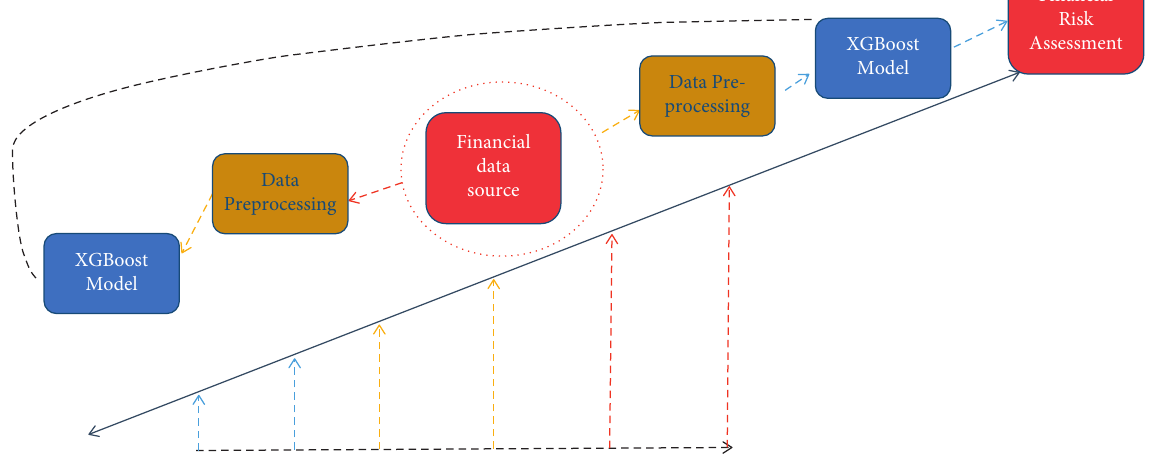
Figure 1: The process of corporate financial risk prediction through the XGBoost